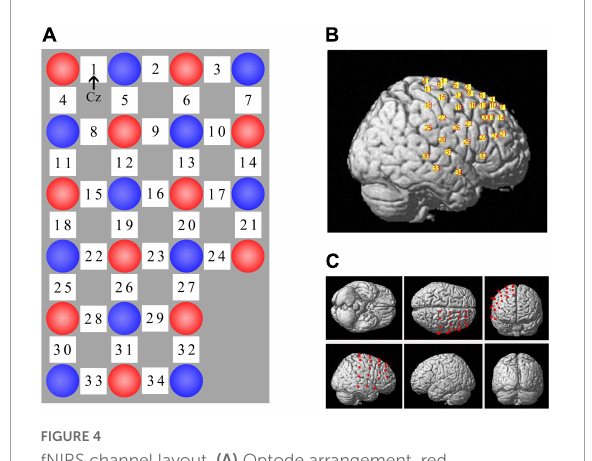
FIGURE4 fNIRS channel layout. (A) Optode arrangement, red circle = source, blue circle = detector, white square = channel. Channel 1 was located at Cz and the uppermost edge (i.e., channel 1 – 3) of the probe set overlapped with Cz-Oz. (B) Spatial registration of channels on a rendered brain. (C) Different views of optode